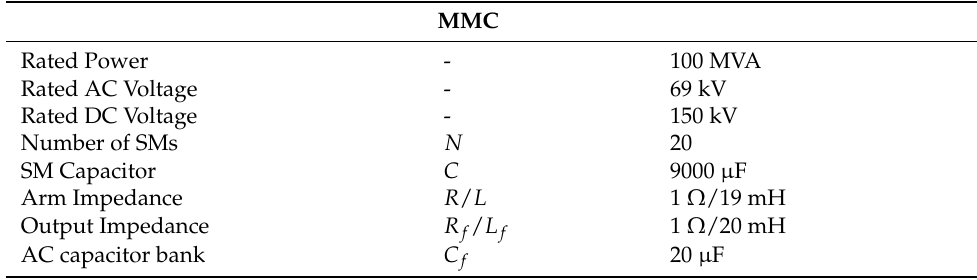
Table A2. Parameters used in MMC.